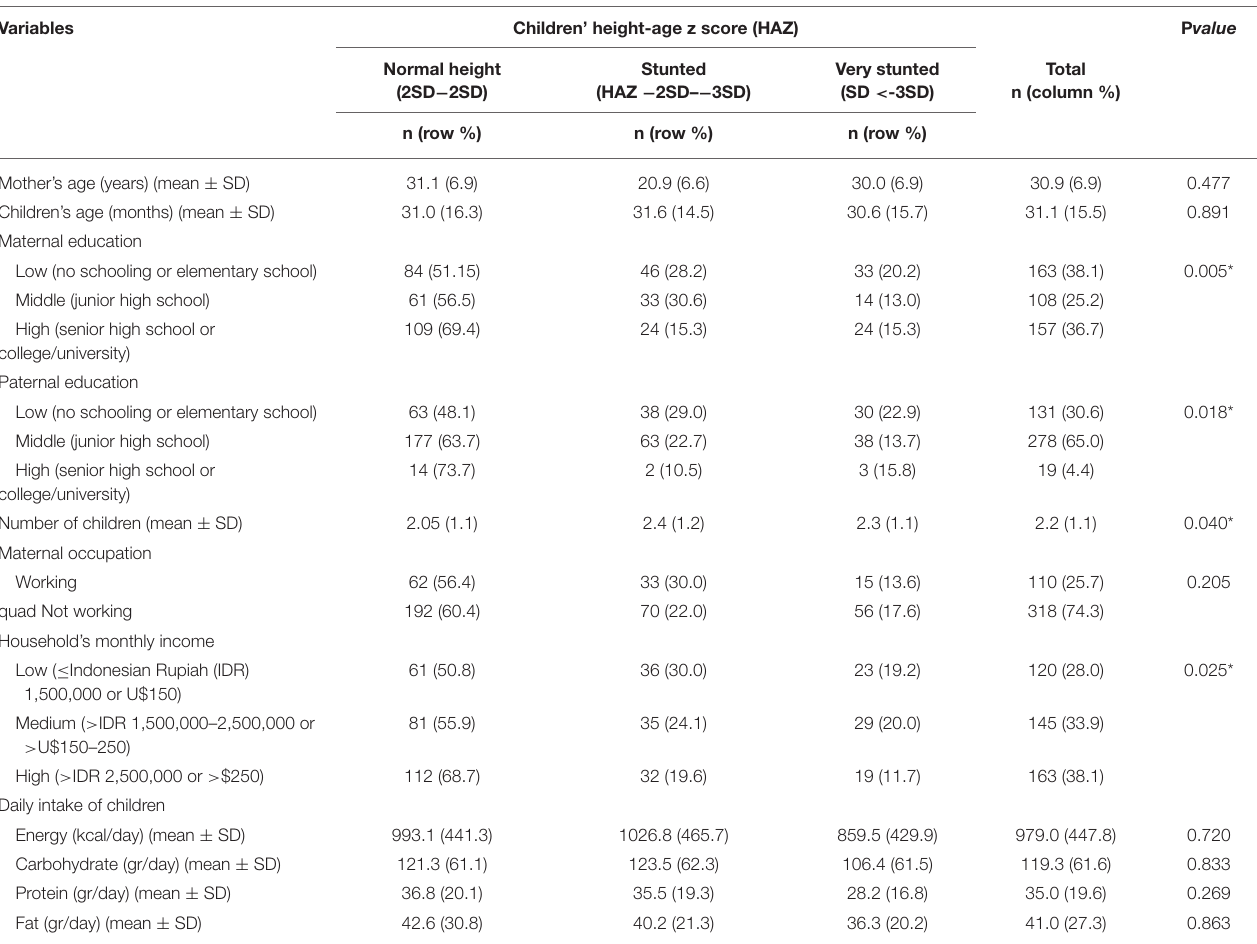
TABLE 2 | The descriptive characteristics of children under-5 years. Variables